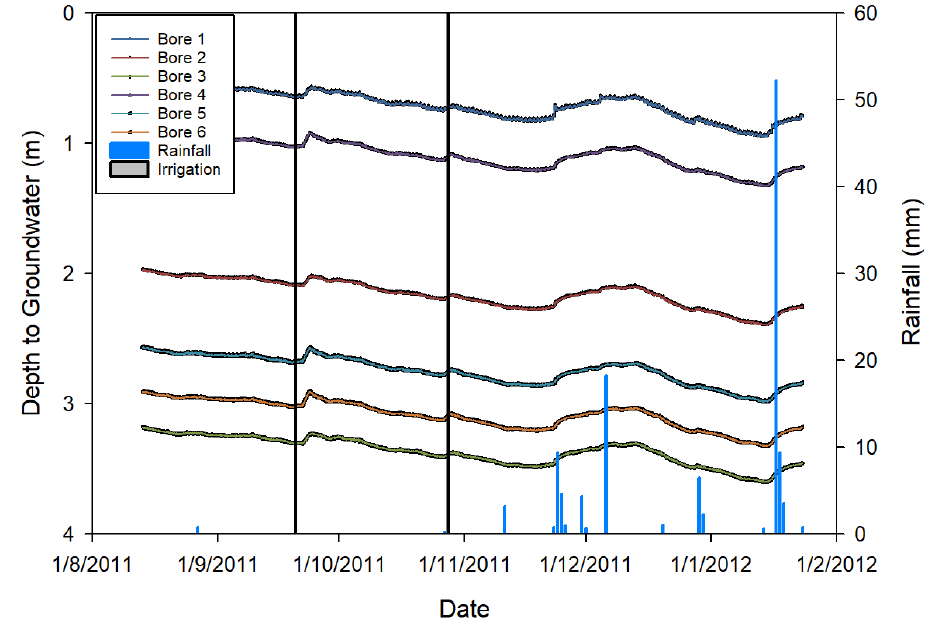
Figure 2. Depth to groundwater for the six bores at the site, versus rainfall, with the timing of irrigation events on the neighboring property depicted by solid grey vertical lines in September and October.